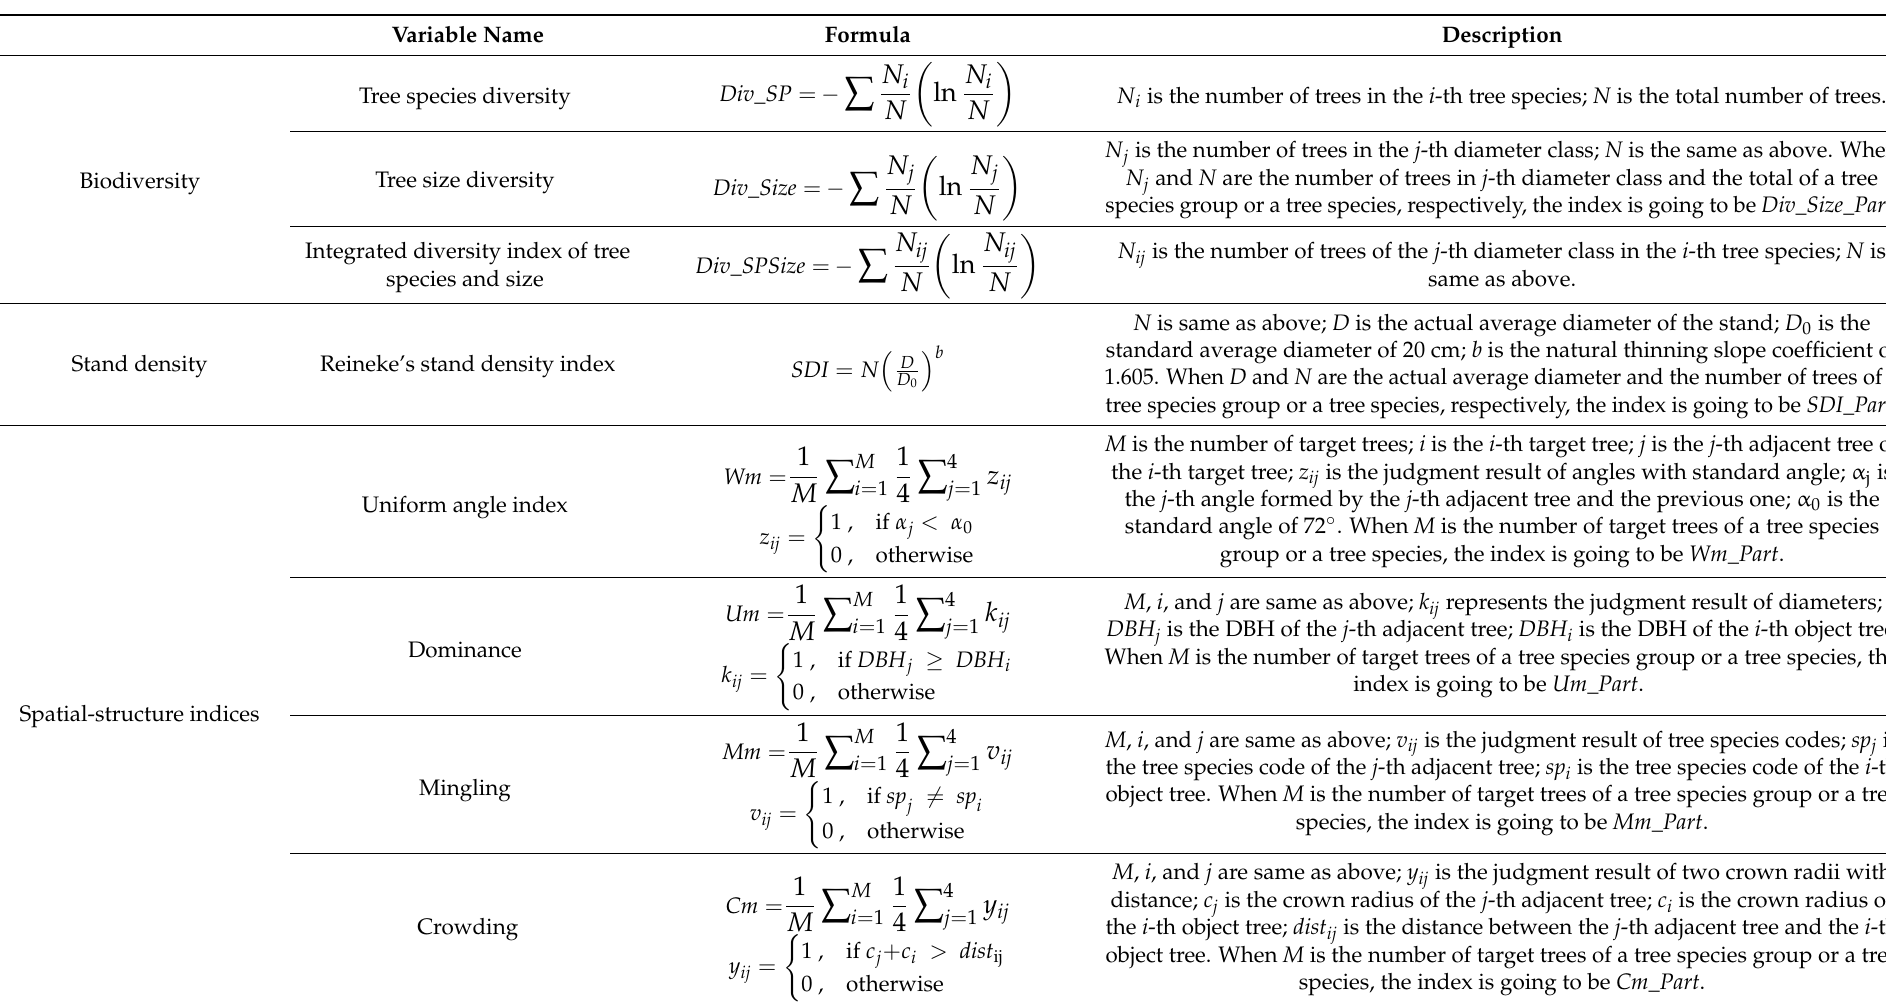
Table 2. List of independent variables and